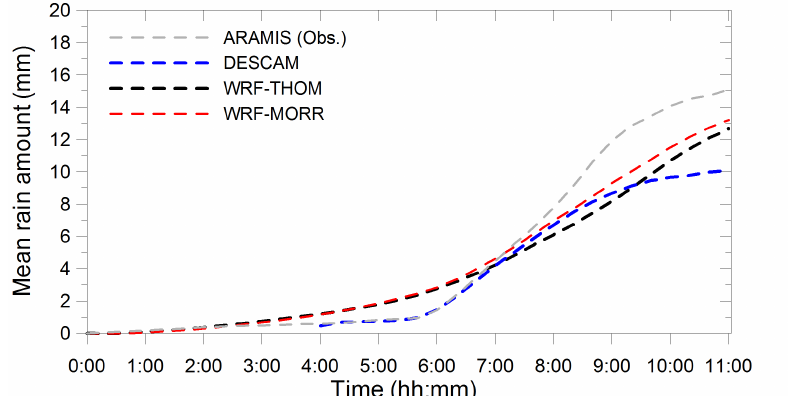
Figure 4. Temporal evolution of the mean accumulated rain amounts in mm in the innermost domain from simulations and retrieved from ARAMIS observations. The averages are obtained considering the grid points where the cumulative rain is ≥ 0.25 mm. The line representing the DESCAM results is shifted to consider the 1 hour delay in the rain